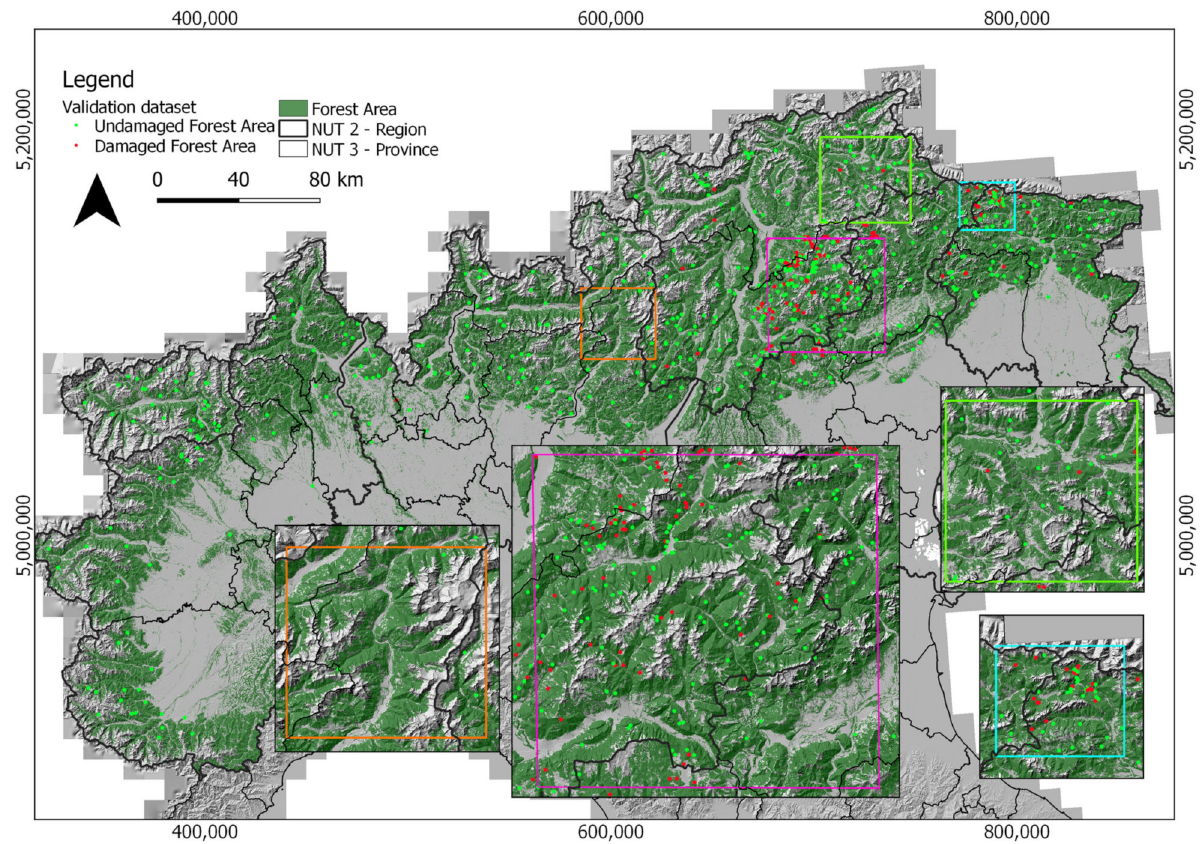
Figure 1. Location of the study area and of the validation dataset. NUT are the “Nomenclature des Unit é s territoriales statistiques” that is the classification of administrative territories at European